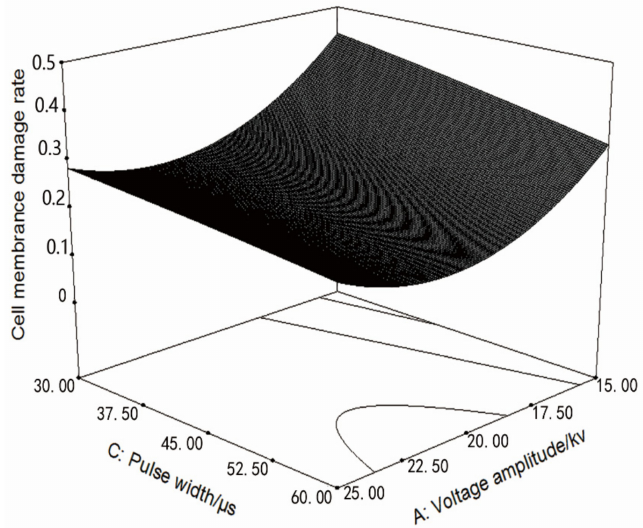
Figure 3. Response surface analysis of voltage amplitude and pulse